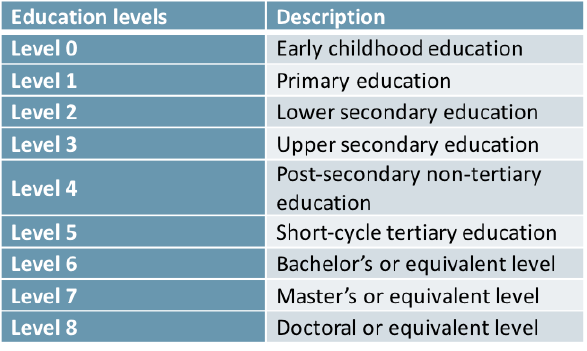
Table 4: Standardized education levels identified by ISCED, ex- tracted from [51].